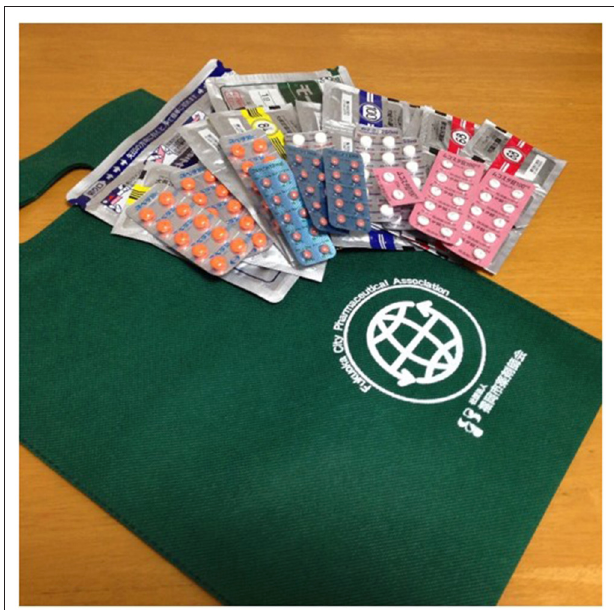
FIGURE 1 | A SETSUYAKU-BAG and leftover drugs brought to pharmacies by